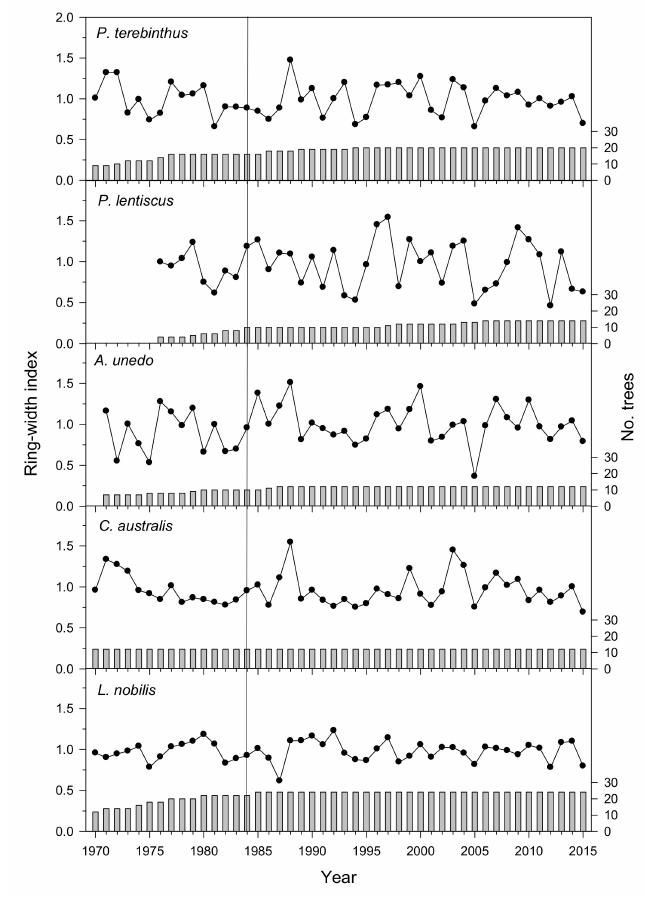
Figure 2. Indexed, mean ring-width series (chronologies) of the five study species. The bars show the sample size (right y axis), i.e., the number of individuals measured each year. The vertical line indicates the best-replicated, common period (1984–2015). Table2. Pearsoncorrelations(valuesbelowthediagonal)andassociatedsignificancelevels(valuesabove the diagonal) calculated for the common period 1984–2015 between the chronologies of the five